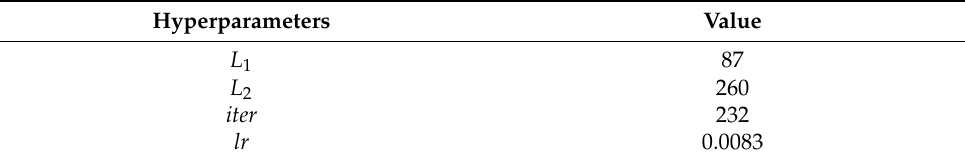
Table 7. Comparison of ISSA-LSTM model output values with real values. Serial No.